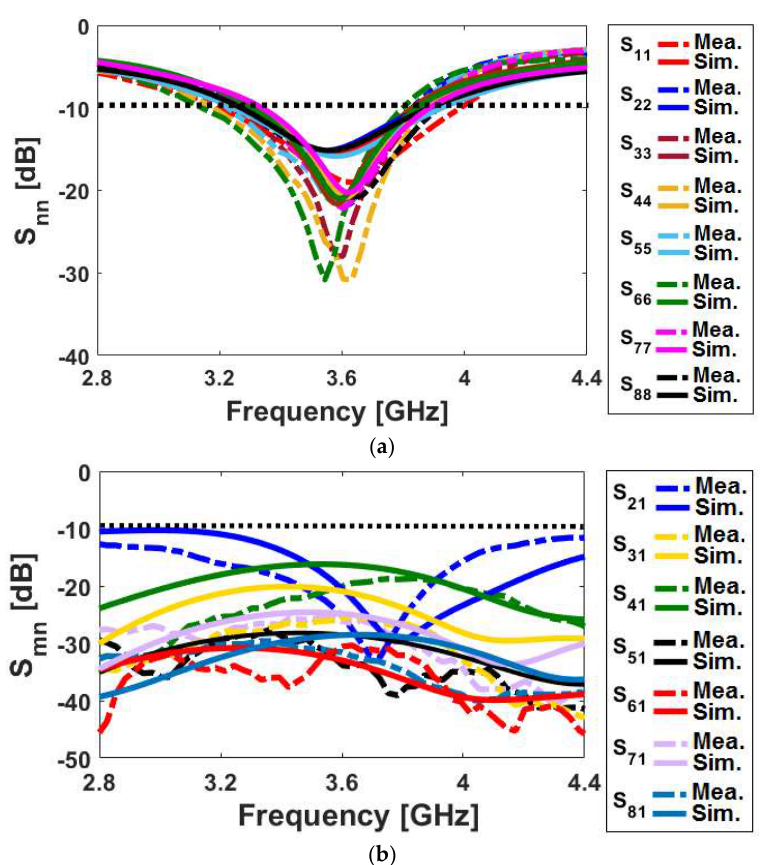
Figure 15. Measured and simulated ( a ) S nn (S 11 –S 88 ) and ( b ) S mn (S 21 –S 81 ) of the fabricated prototype. According to the point that the radiation elements with the same placements and polarizations provide similar radiation patterns, 2D polar radiation patterns of the adjacent resonators (including Ant. 1 and Ant. 2) were measured at center operating frequency (3.6 GHz) and illustrated in Figure 16. As shown, the sample prototype exhibits good radiation patterns and provides acceptable agreement with simulations. In addition, the antenna elements with different polarizations provide sufficient gain values at the center frequency of the operation band.